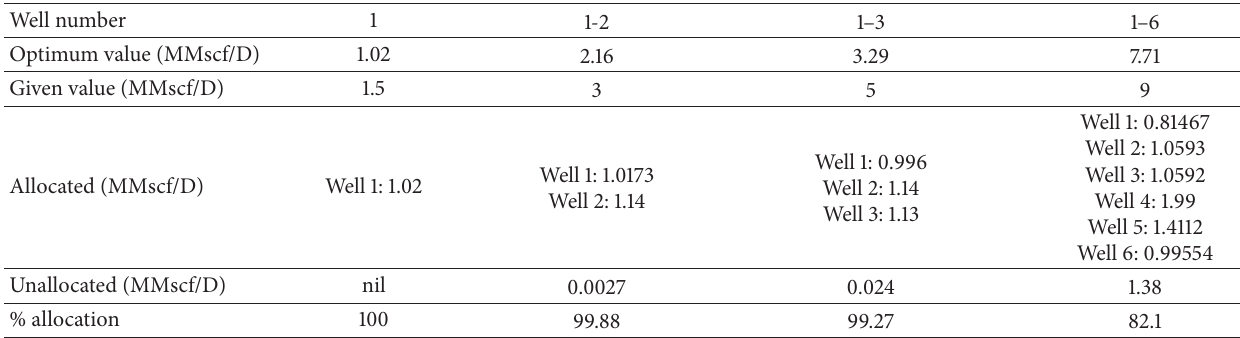
Table 3: Unlimited gas optimization values for different well